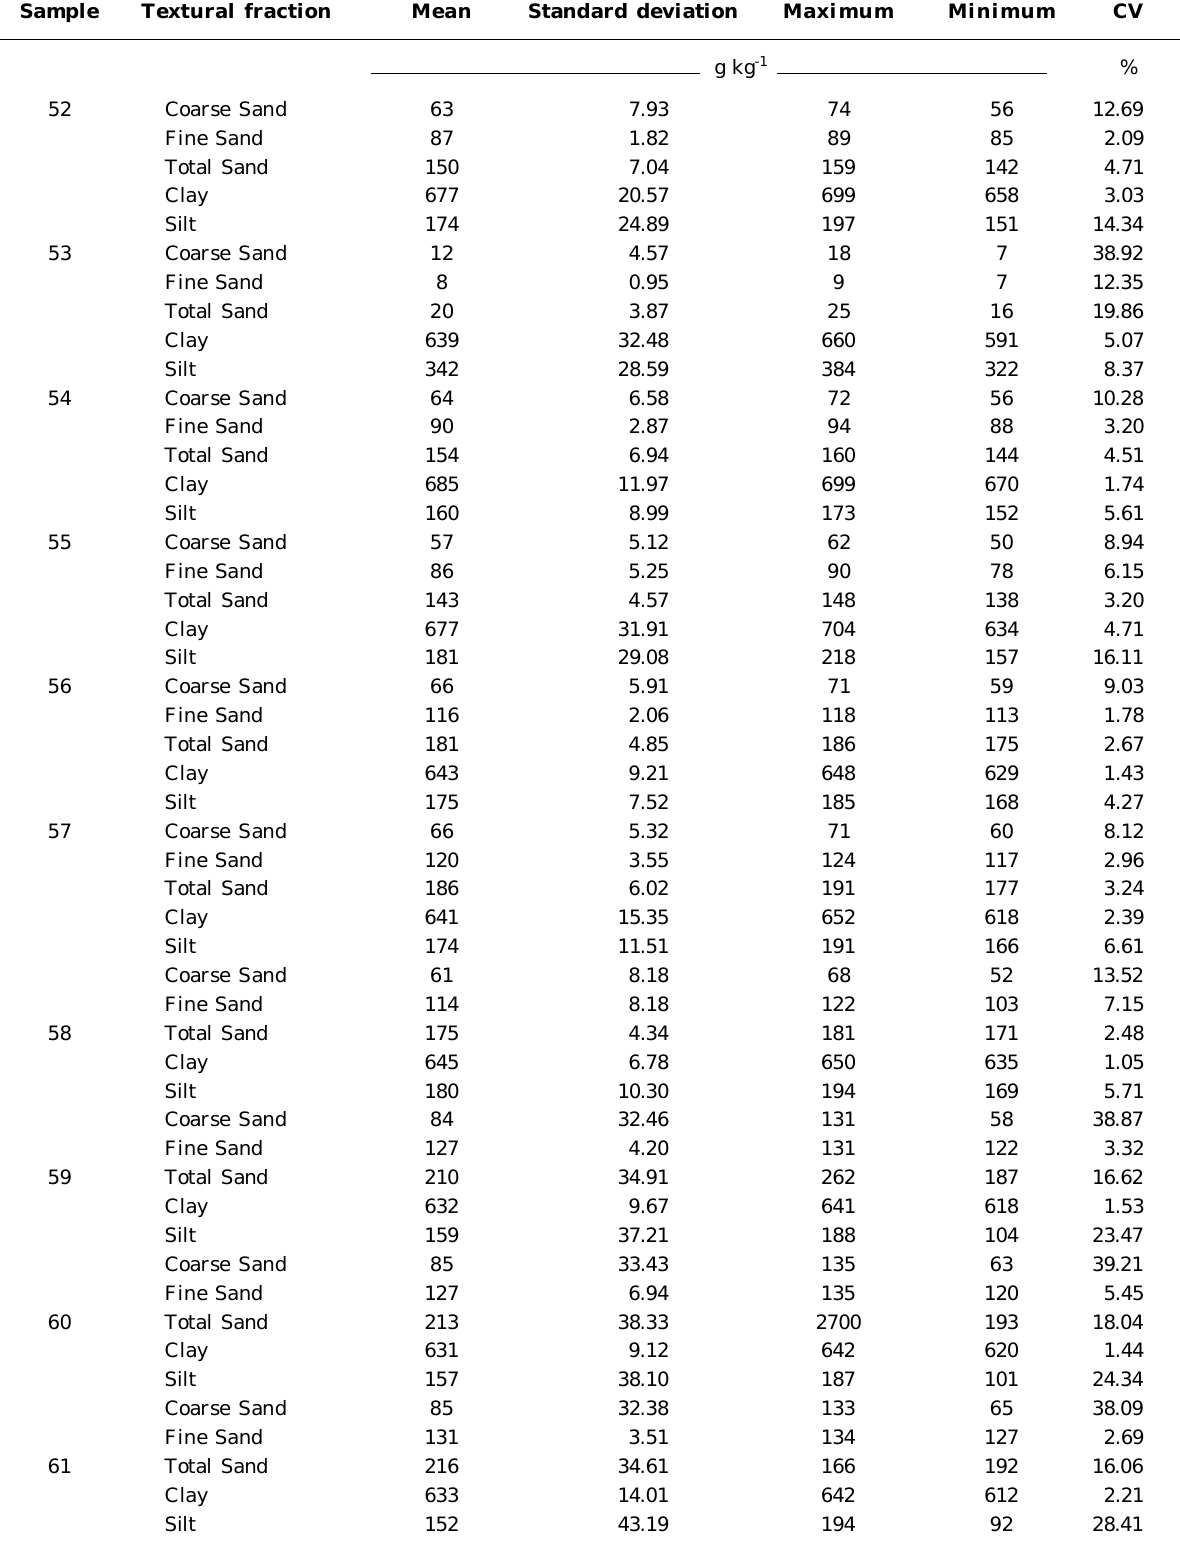
Table 6. Descriptive statistics of the results from particle-size analyses of 10 Heavy clay soil samples (n = 4